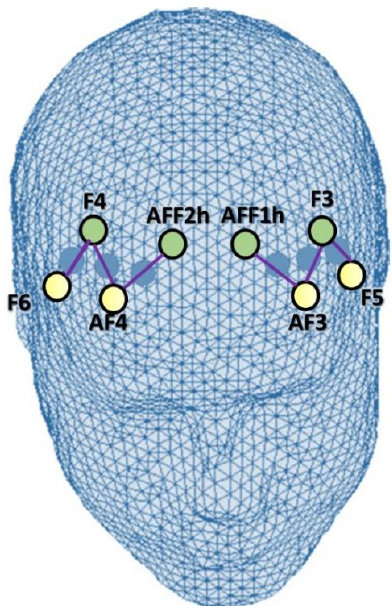
Figure 2. fNIRS montage. Location of the sources (yellow) and detectors (green) of fNIRS montage. Sources were in the following positions: AF3-AF4, F5-F6. Detectors were placed on: AFF1h-AFF2h, F3-F4. A total of six channels (violet) have been acquired: Ch1 (AF3-F3), Ch2 (AF3-AFF1h), Ch3 (F5-F3), Ch4 (AF4-F4), Ch5 (AF4-AFF2h), Ch6